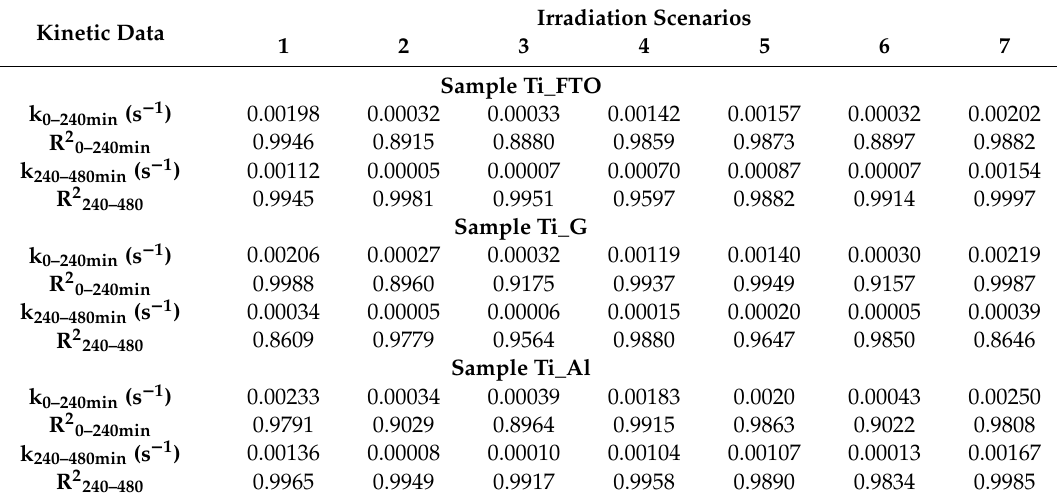
Table 4. Kinetic data corresponding to the Tr